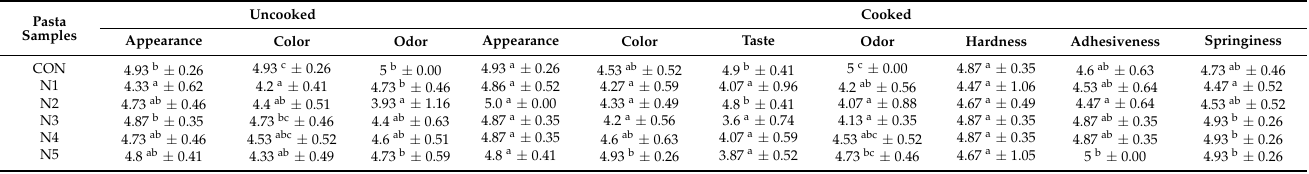
Figure 2. Pasta with 0–5% addition of stinging nettle. Explanation: CON—control sample; N—pasta with stinging nettle. Table 6. Sensory quality of pasta